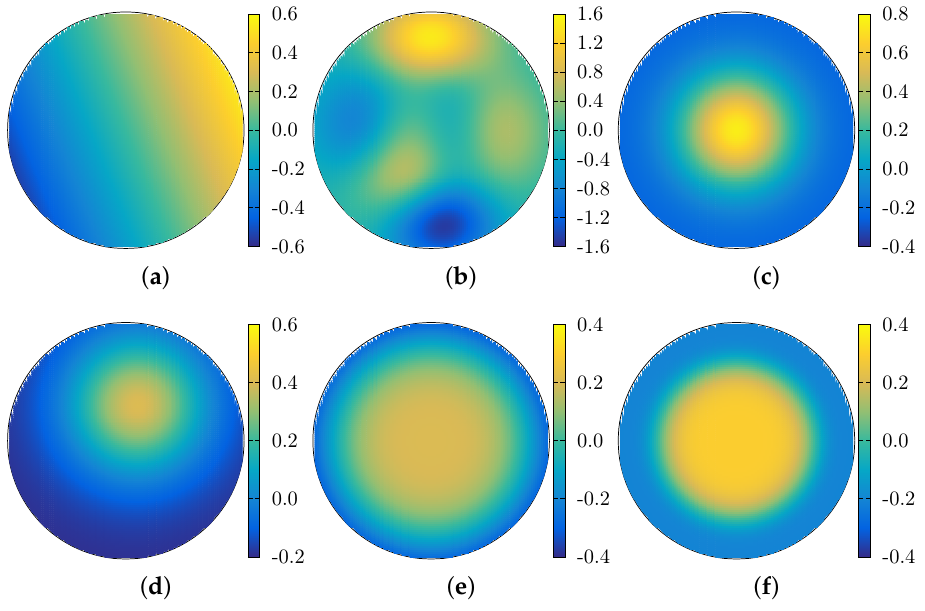
Figure 4. Topview of the wavefronts used to measure the reconstruction algorithm’s accuracy. The functions depicted are as follows. ( a ) a tilted plane, both around the x - and y -axis; ( b ) the function f 1 (see Equation (27)); ( c ) a centered Gaussian; ( d ) and off-centered Gaussian; ( e ) a centered super-Gaussian of order 4; and ( f ) a centered super-Gaussian of order